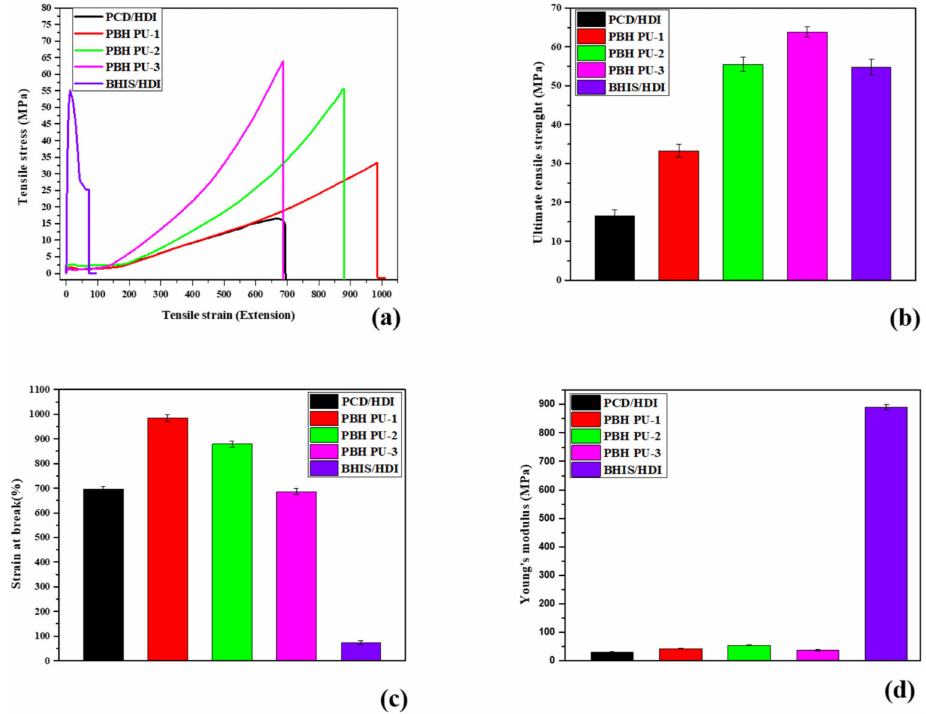
Figure 7. Mechanical property data of polyurethane films. ( a ) Tensile stress, ( b ) ultimate tensile strength, ( c ) strain at break, and ( d ) Young’s